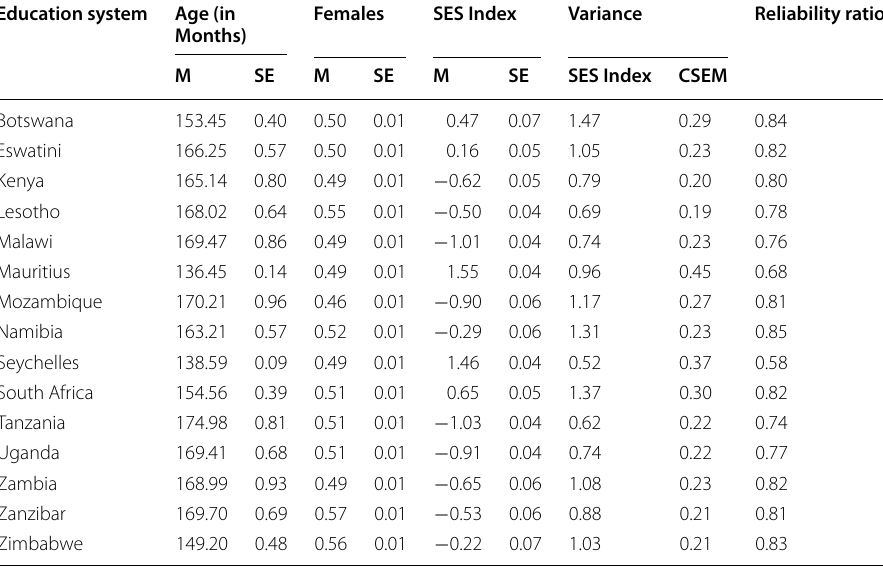
Table 2 Student and family background descriptive